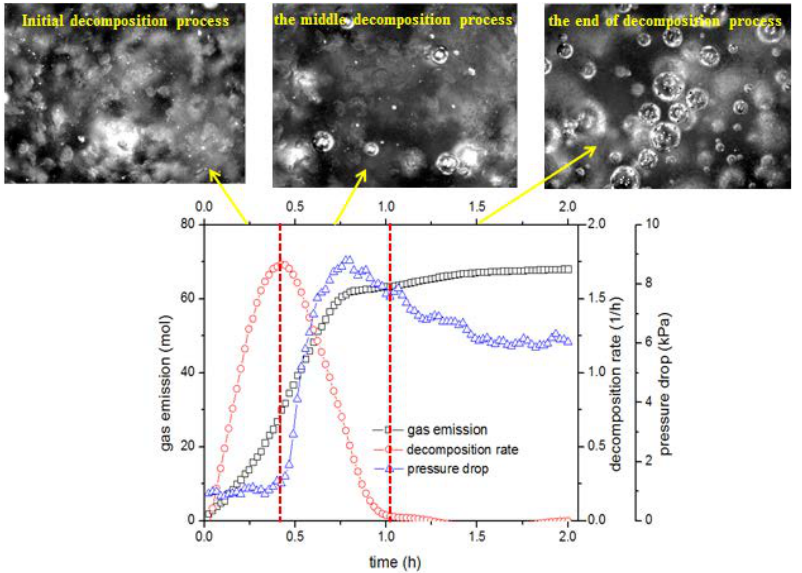
Figure 5. Gas emission quantity, decomposition rate, and pressure drop curves during the hydrate